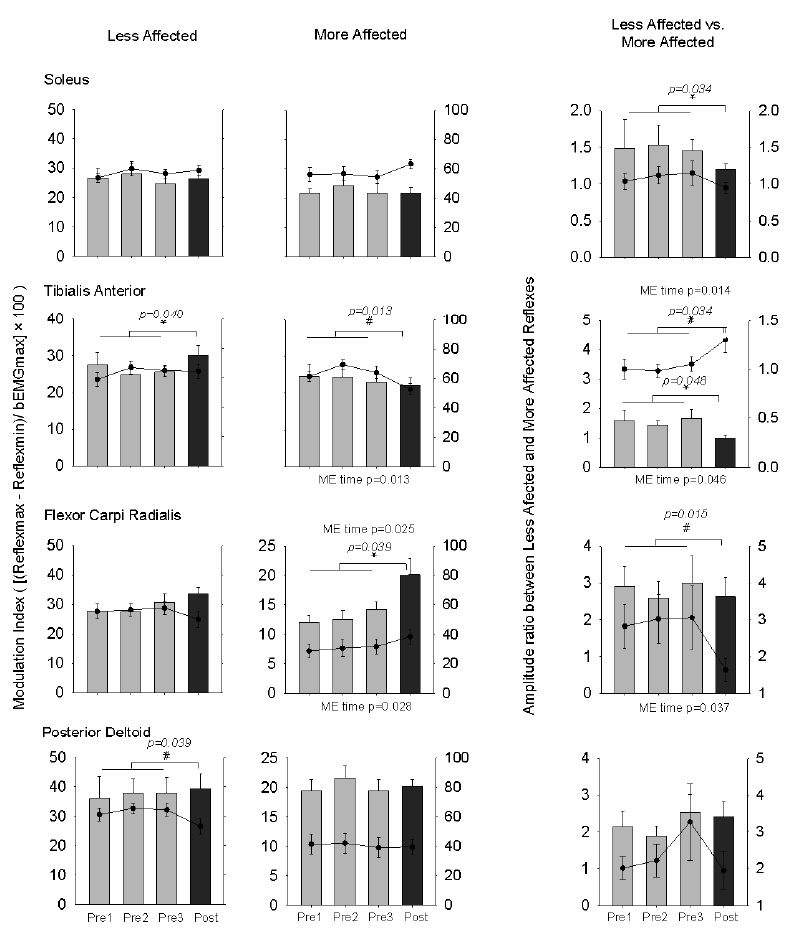
Figure 8. Modulation indices and amplitude ratios for reflexes for all muscles during A & L cycling. Bar graphs are means ( ± standard error) averaged across all participants for baseline and post-test values. Line graphs are means ( ± standard error) for bEMG. Repeated-measures ANOVA was used to assess the effects of A & L cycling training with significance set at p < 0.05. Main effects (ME) are listed for reflexes above each subplot and ME are listed for bEMG below each panel. For comparison between baseline average and post-test data, p -values are shown for each test. * For cutaneous reflex and # for bEMG indicates significant differences between the pretest average and the post-test